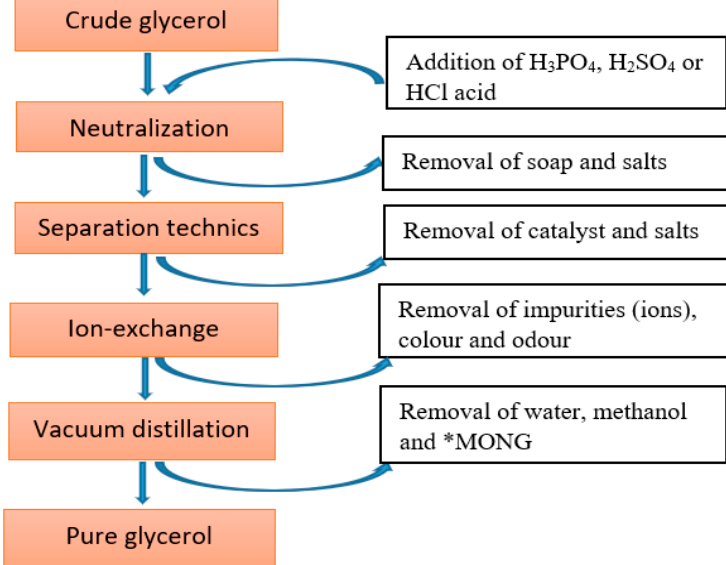
Figure 3. Crude glycerol purification process. * Matter organic non-glycerol.